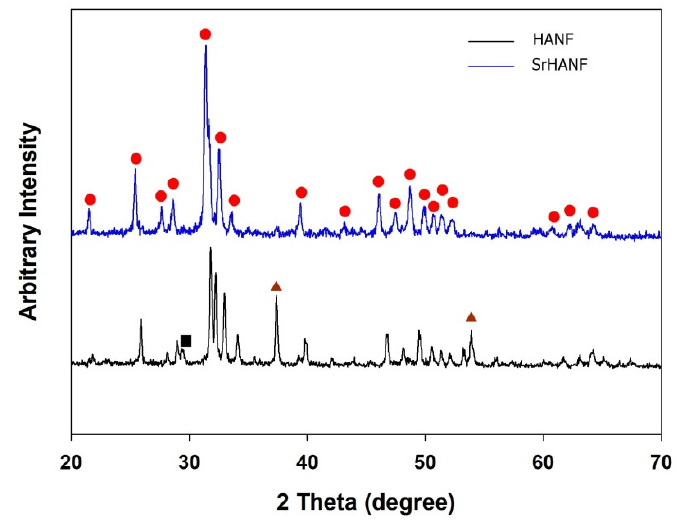
Figure 2. Determination of crystallographic phases of matrix. XRD patterns of SrHANF and HANF. ( ▲ : CaO; ● : HA/SrHA; ■ : CaCO 3 ).